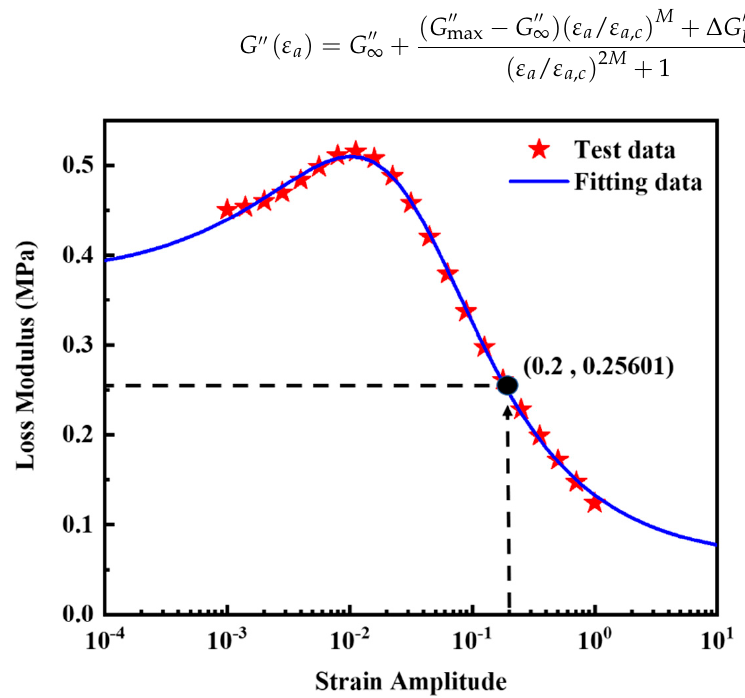
Figure 10. Test data of G ″ vs. ε a and fitting data of the silica filled S − SBR material at a constant frequency of 10 Hz and a constant temperature of 25 °C. The coefficient of determination R 2 is 0.9988.